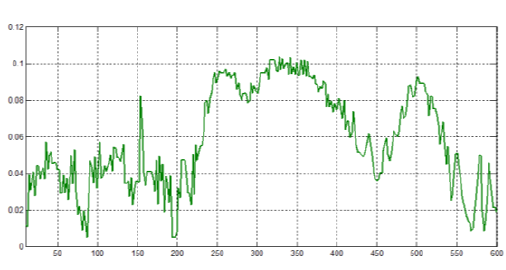
Figure 12. The error of path